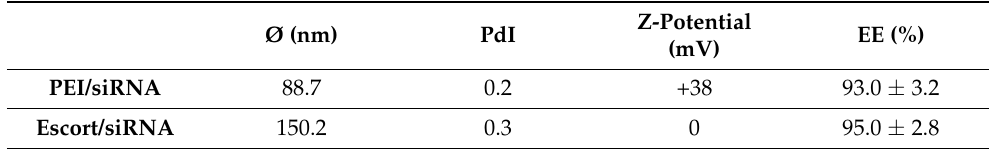
Table 6. Hydrodynamic diameter, PdI, Z-potential and entrapment efficiency (EE) of PEI/siRNA and Escort/siRNA.